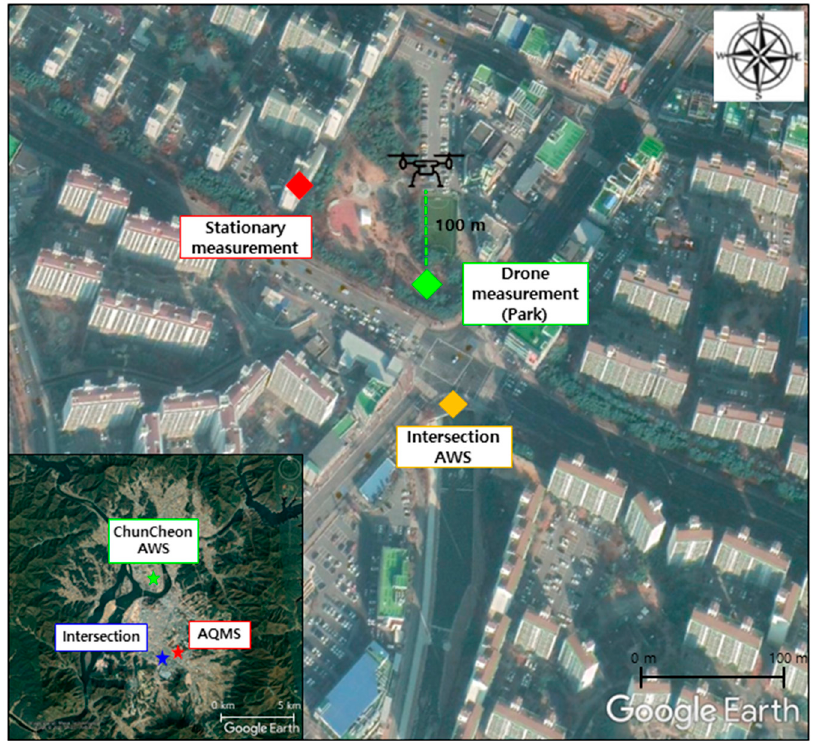
Figure 1. Measurement locations near the Toegye Intersection in Chuncheon, Gangwon Province, Republic of Korea. The map at the left bottom corner shows the entire Chuncheon basin. The Chuncheon AWS (automatic weather station) and the AQMS (air quality monitoring station) are located at approximately 5 km north and 1 km northeast of the intersection,